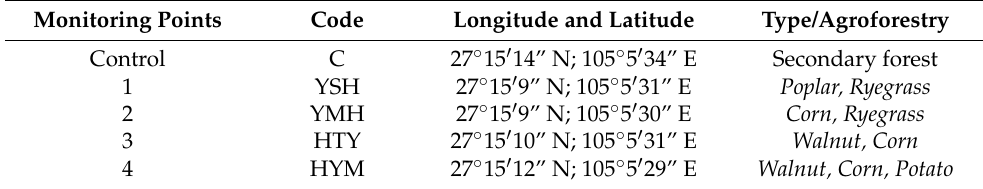
Table 1. Information for each monitoring